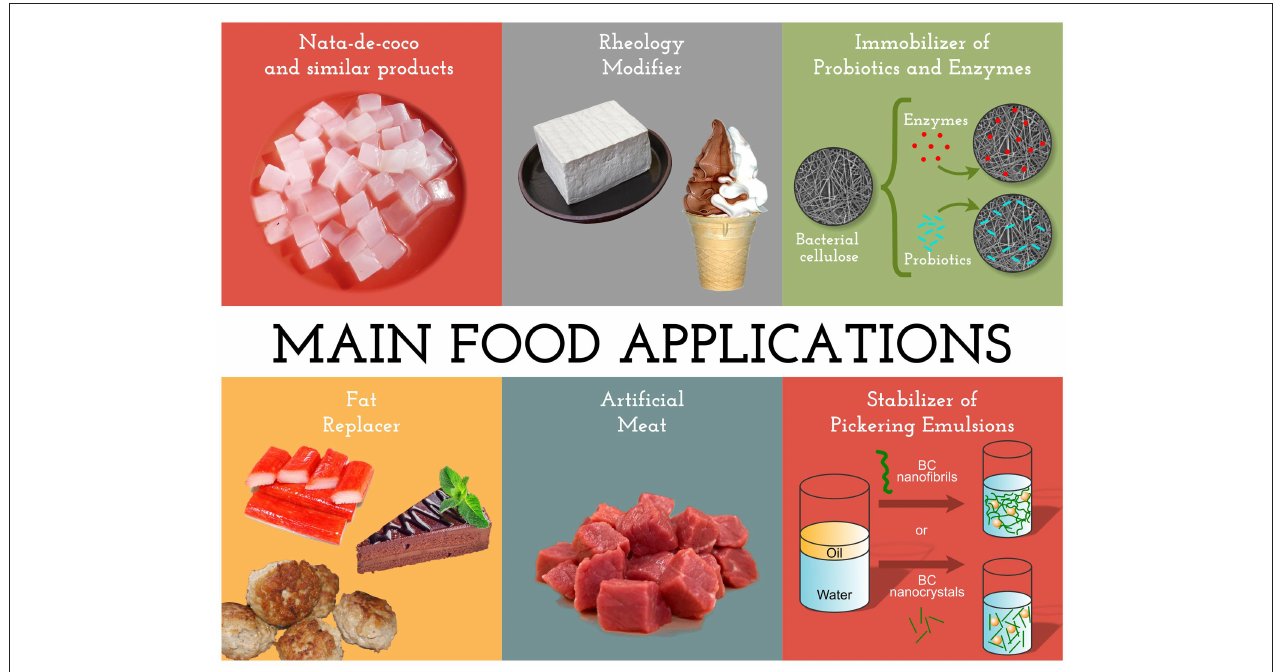
FIGURE 3 | Main food applications of bacterial